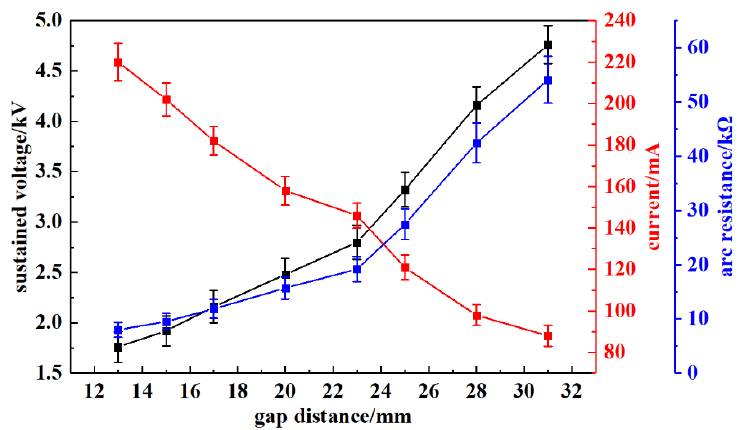
Figure 4. The sustained voltage, discharge current, and arc resistance as a function of gap distance.